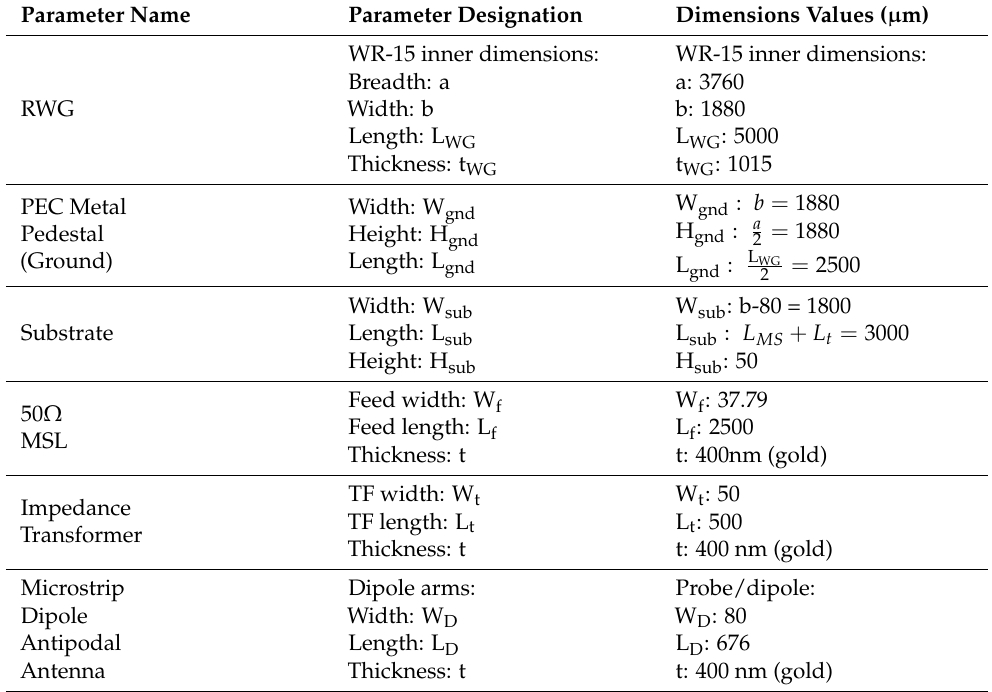
Table 1. Dimensions of the designed MSL-to-RWG waveguide transition.